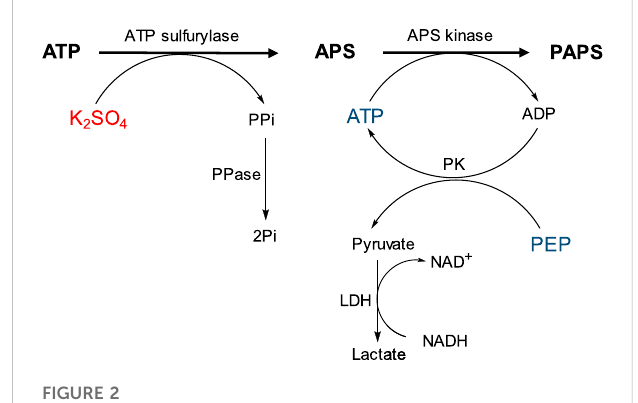
FIGURE 2 Schematic representation of the coupled spectrophotometric assay that allows measurement of PAPSS1 activity by the concomitant oxidation of